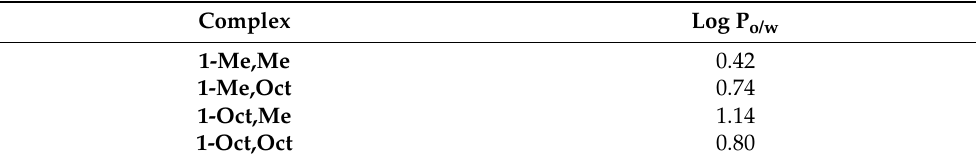
Table 1. Octanol/water partition